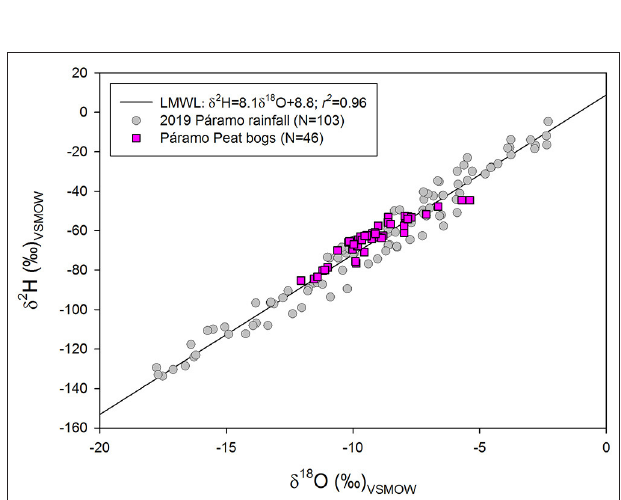
FIGURE 4 | Dual isotope diagram including peat bogs (pink squares) and rainfall (gray dots) during the 2019 hydrological year at the Páramo ecosystem. The local meteoric water line (LMWL) during 2019 (black line) is included as reference (Esquivel-Hernández et al., 2021).